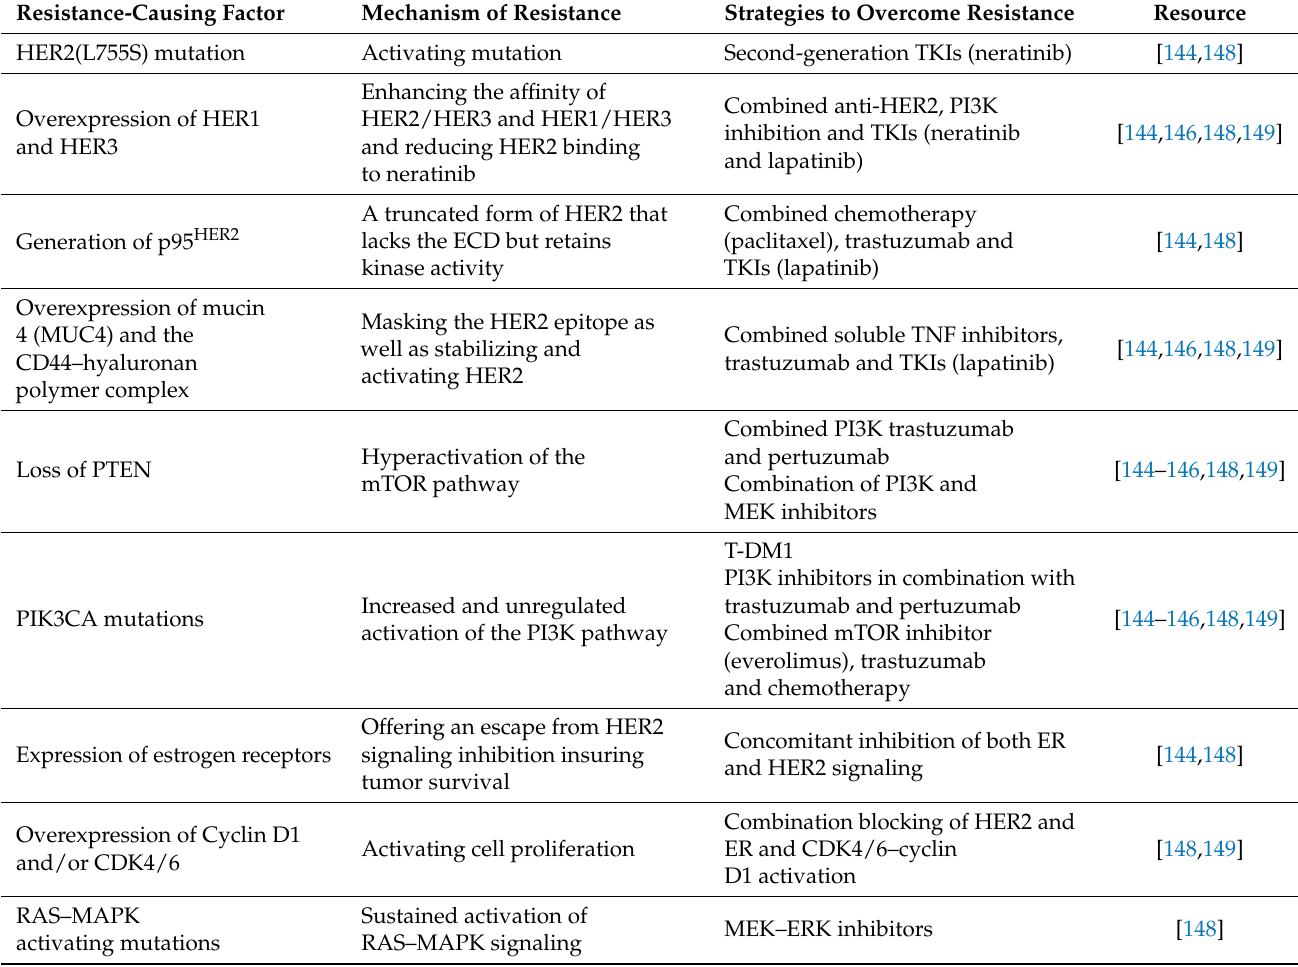
Table 3. Mechanisms of resistance to HER2-targeted